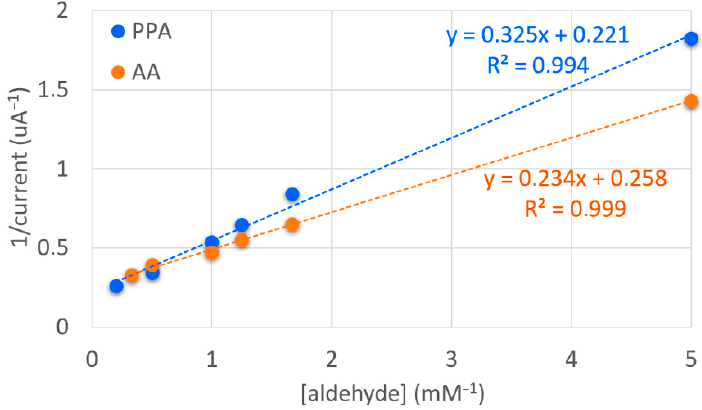
Figure 1. Lineweaver-Burk plot obtained for different concentrations of PPA (blue dots) or AA (orange dots) in 0.39 U/mL ALDH, 0.39 U/mL DP, 1 mM NAD + , 1 mM K 3 [Fe(CN) 6 ], 0.1% BSA in 0.1 M phosphate + 0.1 M KCl buffer solution pH 8.0.